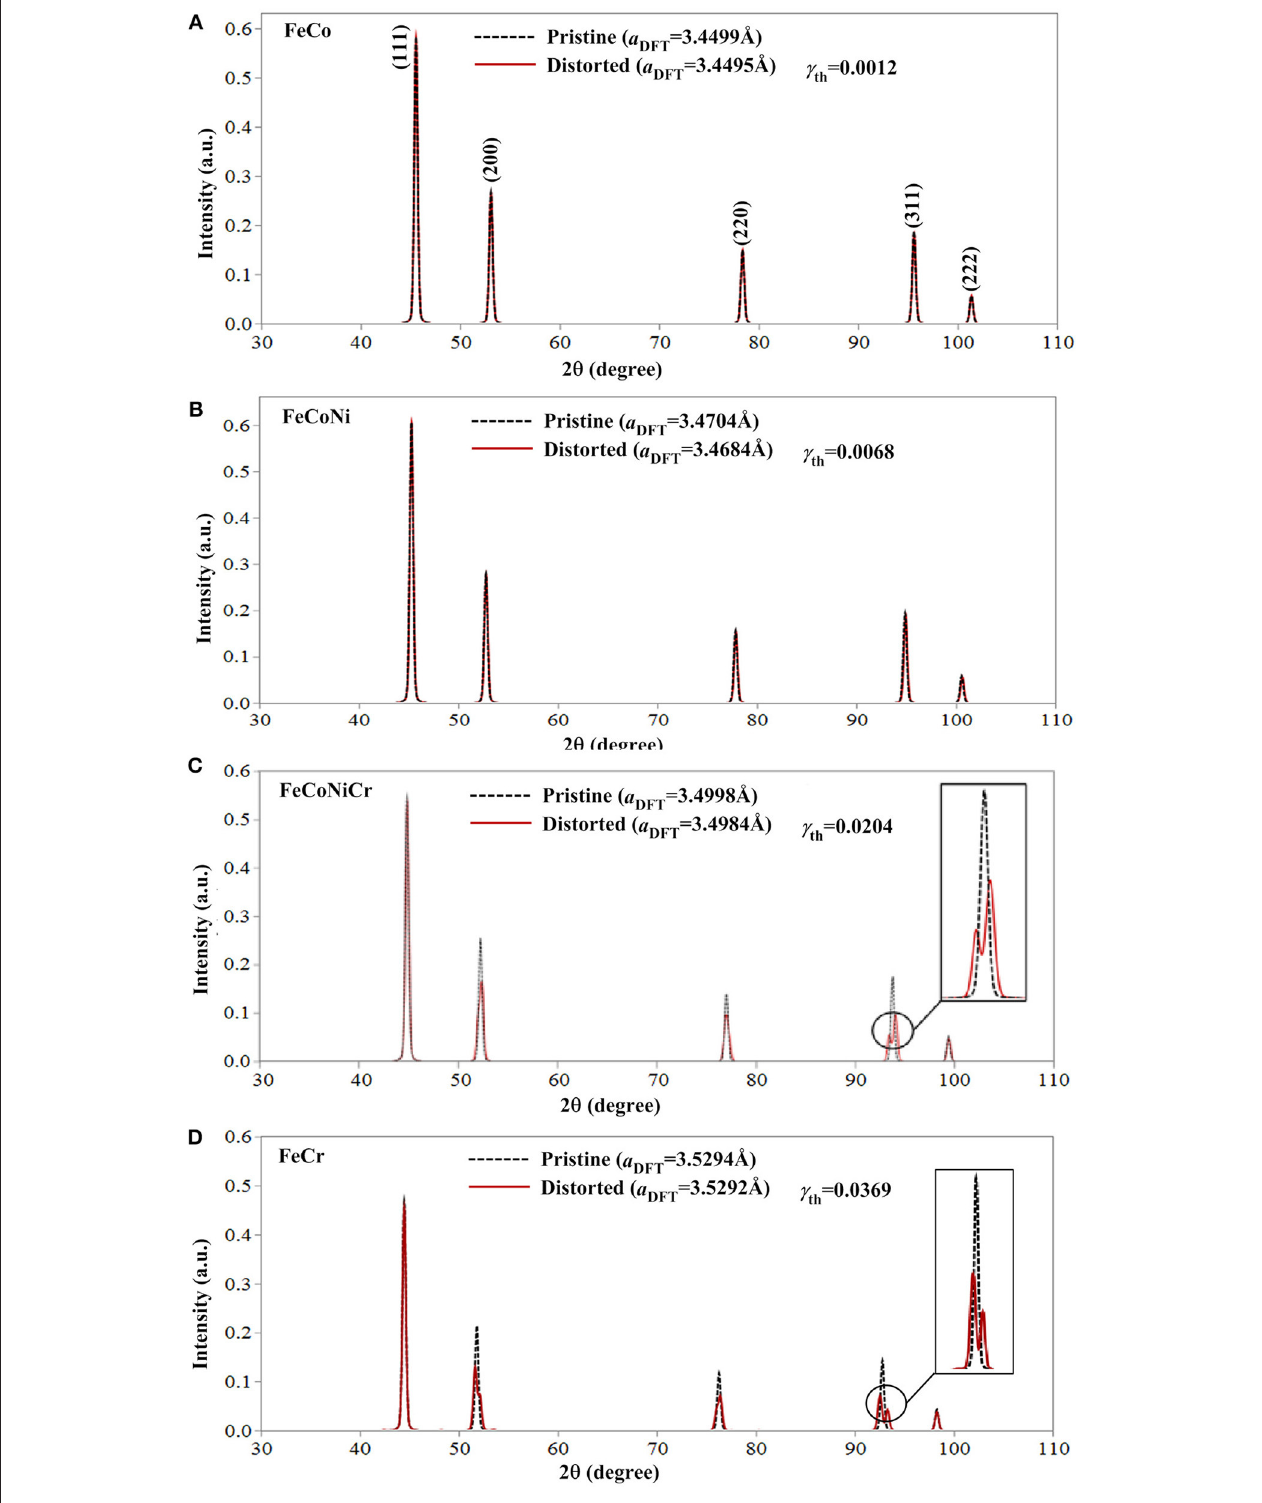
FIGURE 7 | The simulated XRD results of pristine (black dash line) and distorted lattice (red solid line) of (A) FeCo, (B) FeCoNi, (C) FeCoNiCr, and (D) FeCr with a FCC structure. With the increasing of the average effective shear strain, diffraction peak splitting occurs implicative of lattice distortion.